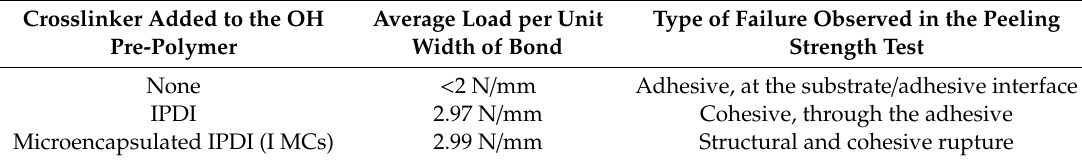
Table 3. Peeling strength tests’ results